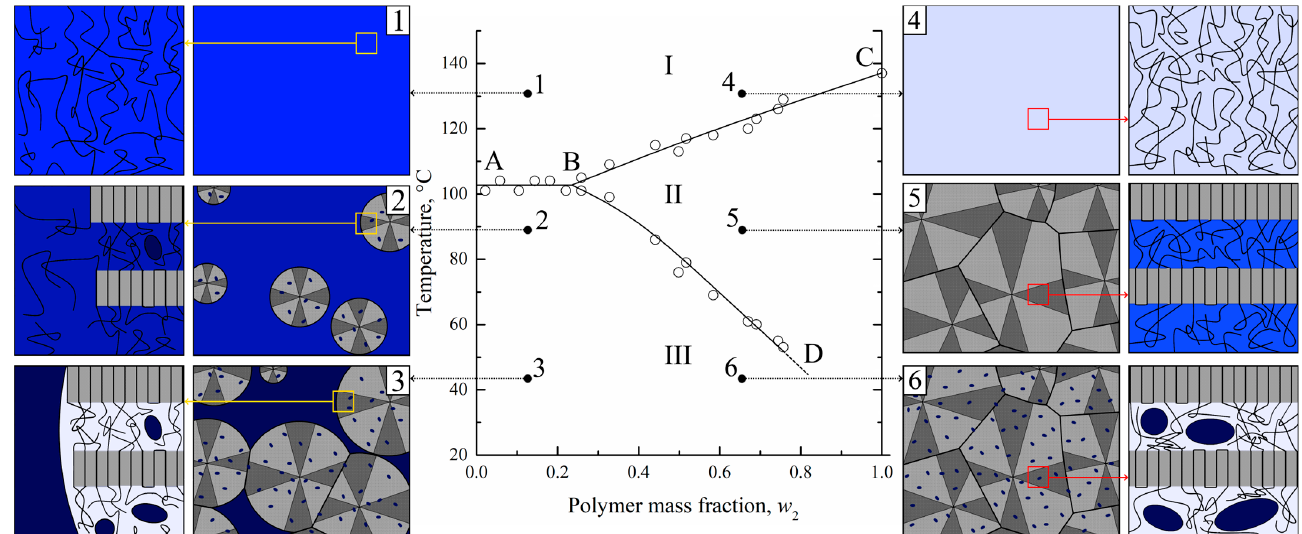
Figure 2. The phase diagram for the HDPE–m-xylene mixture [27] constructed by optical method and schemes [31], illustrating structure evolution on a micro- and nanoscale during cooling of the solvent-enriched (1–3) and polymer-enriched (4–6) homogeneous mixtures. Blue color intensity stands for the solvent concentration. Adapted with permission from L.N. Mizerovskii, T.N.